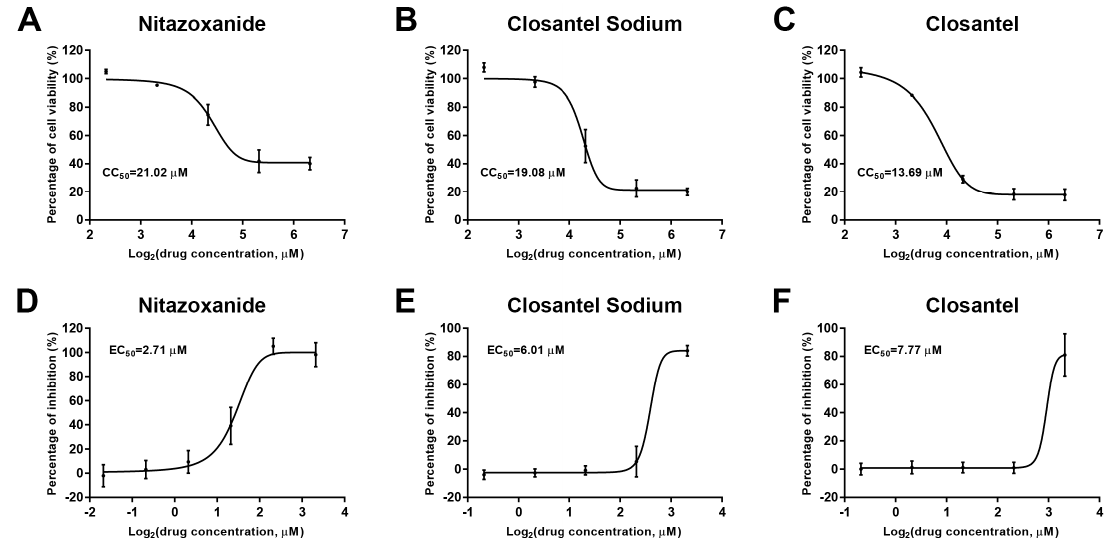
Figure 2. Evaluation of cytotoxicity and anti-CPV e ffi cacy of three identified drugs. Dose-dependent curves show cell viability of F81 cells with 2-fold serial dilution concentrations of Nitazoxanide ( A ), Closantel Sodium ( B ), and Closantel ( C ). Dose-dependent curves show the anti-CPV e ffi cacy of 2-fold serially diluted Nitazoxanide ( D ), Closantel Sodium ( E ), and Closantel ( F ). Error bars represent standard errors from three independent experiments. The CC 50 s and EC 50 s were determined by a best-fit Log(dose)-response curve-fitting in GraphPad Prism 7. 50% cytotoxicity concentration (CC 50 ), 50% antiviral e ffi cacy concentration (EC 50 ), and selectivity index (SI) of identified anti-CPV